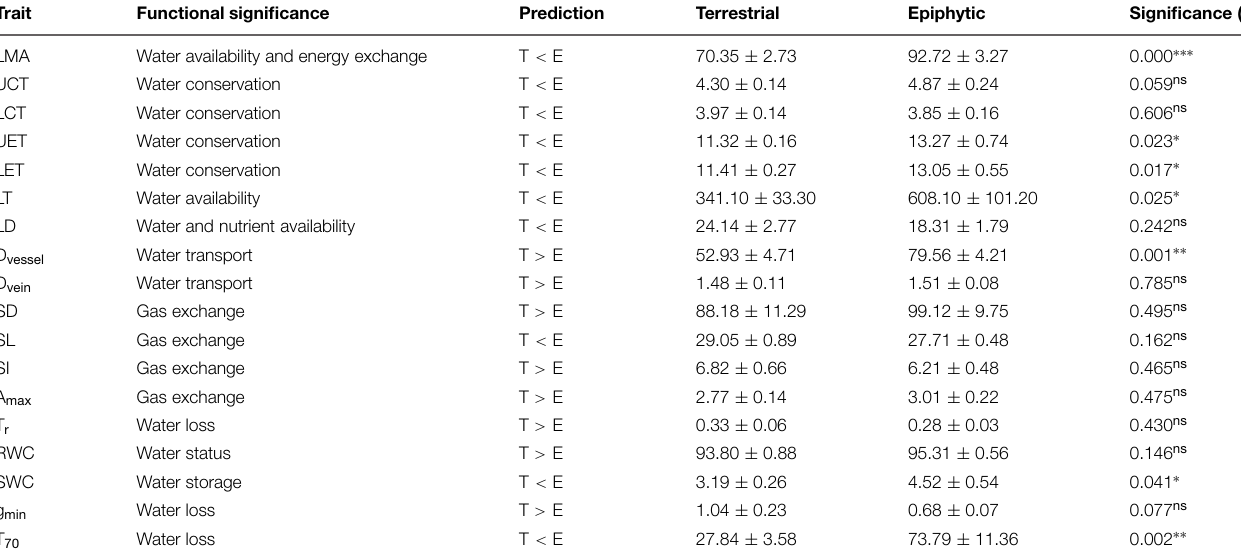
TABLE 2 | Contrasts in leaf traits between terrestrial (T) and epiphytic (E) Cymbidium